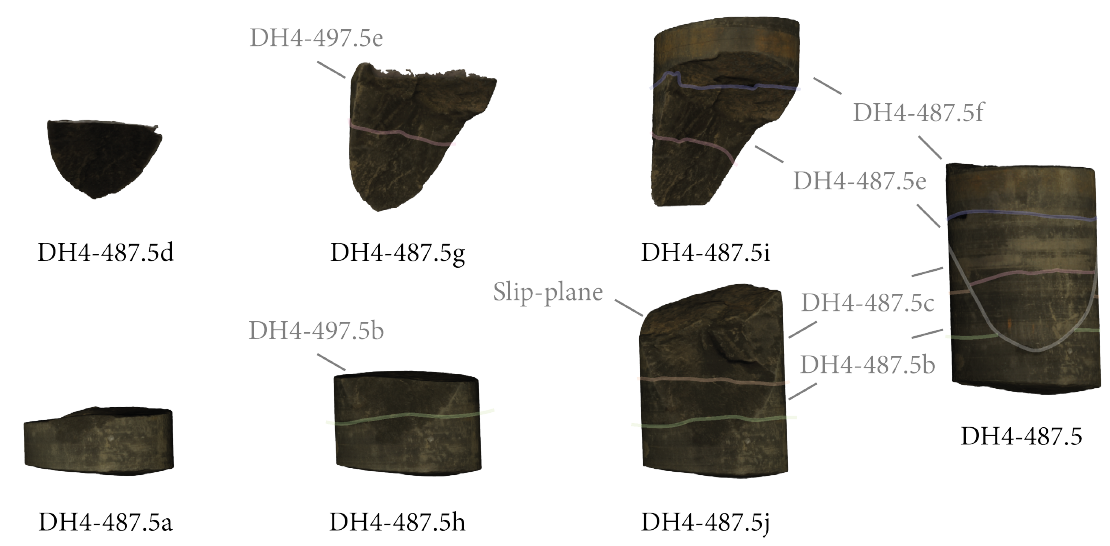
Figure 8. Various stages of composite DCM reconstruction. DH4-487.5i and j complement each other across a slip surface and fracture to form DH4-487.5. The slip surface and fracture align with an anomaly observed in televiewer data at the corresponding interval (see Figure